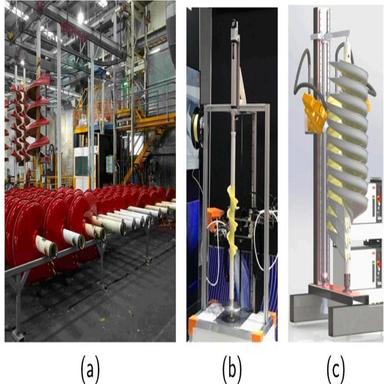
a) A GSS manufacturing facility; b) developed one-third scale printer; c) design of the full-scale printer.